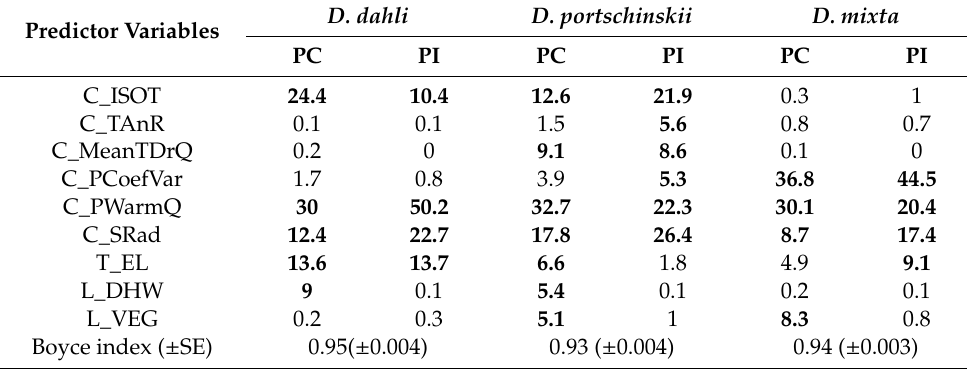
Table 2. Table of contribution of the most important variables obtained by Maxent SDMs. Significant contributions of variables are bolded, where PC is a percentage of contribution, PI is permutation importance.